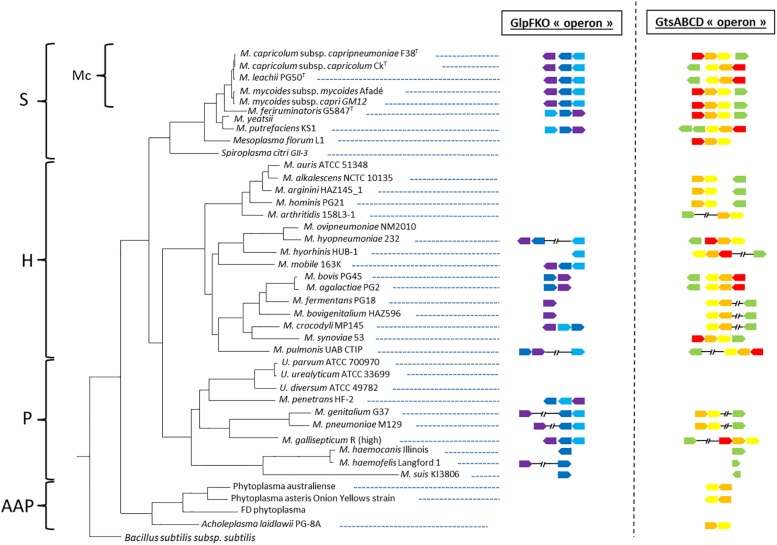
Distribution of the glpFKO and gtsABCD clusters for different species spanning the entire class of Mollicutes. The presence of a gene is indicated by an arrow mimicking the coding sequence orientation and colored in violet (glpF), dark blue (glpK), light blue (glpO), red (gtsA), orange (gtsB), yellow (gtsC), and green (gtsD). Main phylogenetic groups are indicated: S, Spiroplasma; Mc, Mycoides cluster; H, Hominis; P, Pneumoniae; and AAP, Acholeplasma/Phytoplasma.